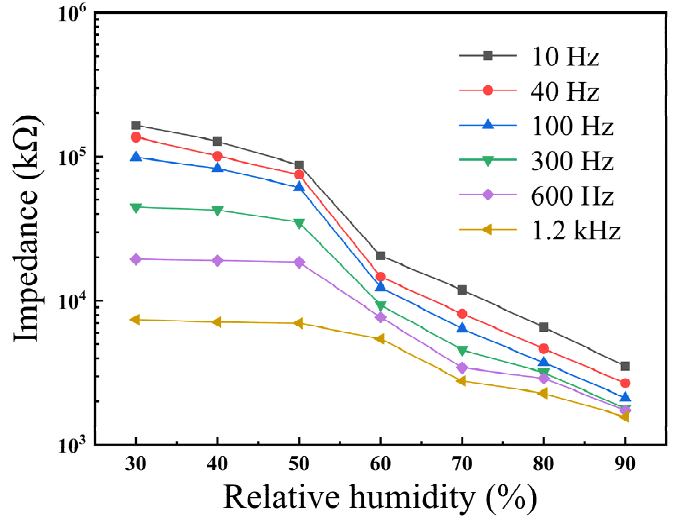
Figure 4. RH dependence on the impedance of BiFeO 3 film. Humidity hysteresis of the BiFeO 3 film usually occurred during the desorption of samples. The humidity hysteresis is a critical characteristic for the application of humidity sensing, and is defined as the maximum difference between adsorption and desorption of the humidity sensor. The humidity hysteresis ( γ H ) is expressed in Equation (2) as [21]: